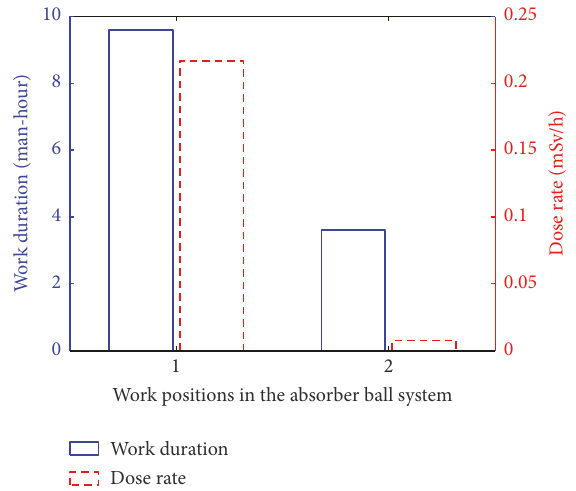
Figure 12: Dose rates and work durations of the absorber ball